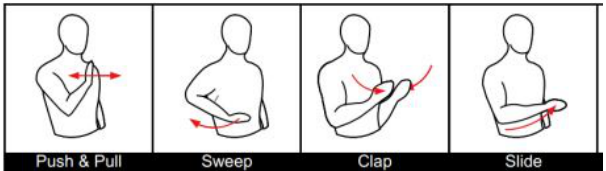
Figure 8. Widar3.0 dataset gesture samples, taken from [5].